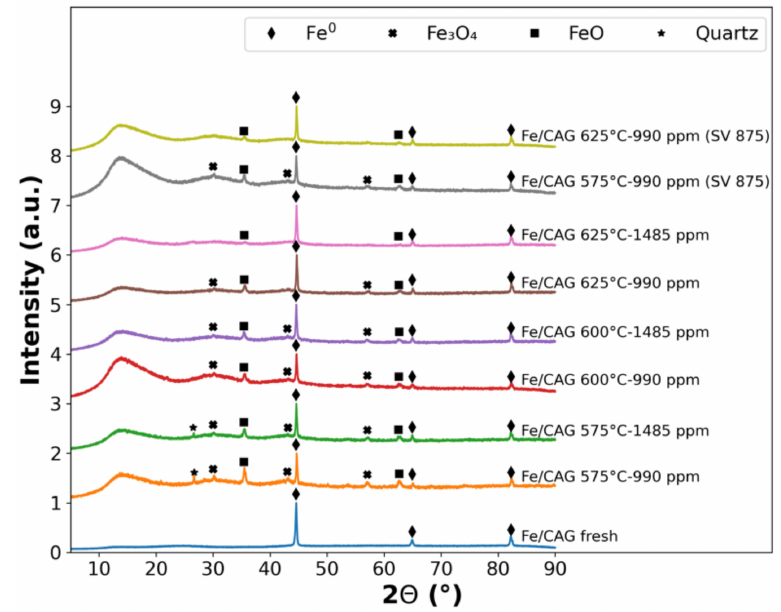
Figure 5. Normalized XRD patterns of fresh and spent catalysts during toluene decomposition. Each pattern is identified with the corresponding spent catalyst condition, temperature, and toluene concentration in the feed. All experiments were carried out at 700 mL/(min · g cat ), except for the spent catalyst marked SV 875, which was performed at 875 mL/(min · g cat ).